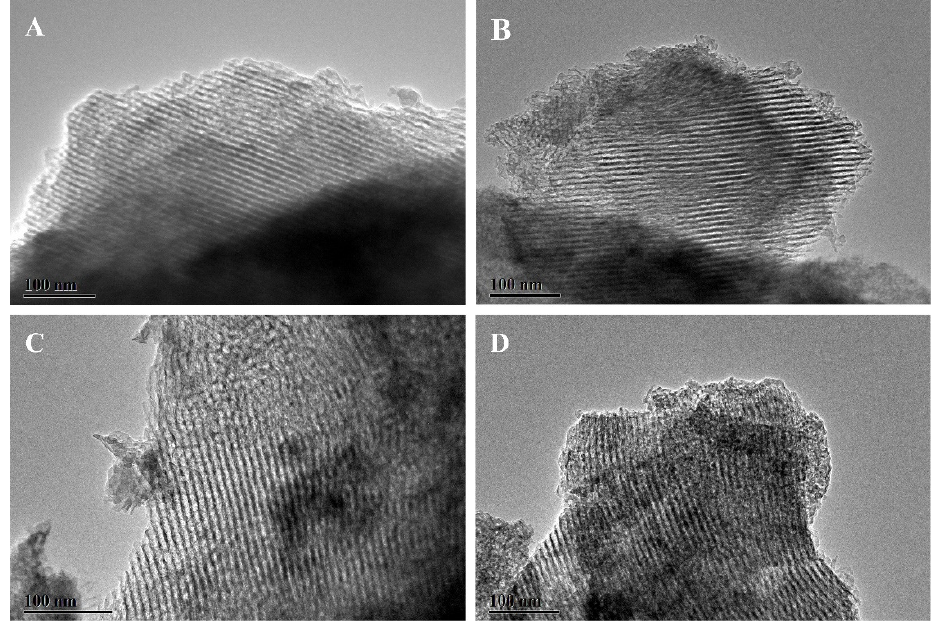
Figure 4. TEM images of ( A ) MnAlO x -450 °C, ( B ) MnAlO x -550 °C, ( C ) MnAlO x -700 °C, ( D ) MnAlO x -800 °C.